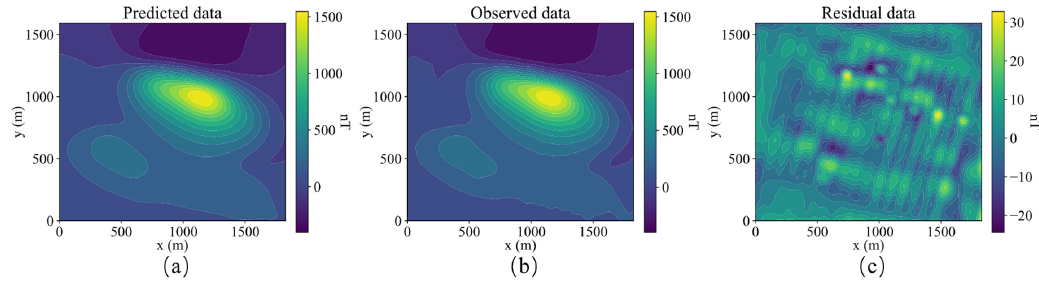
Figure 17. Contour plots of predicted data ( a ), observed data ( b ) and residual data ( c ). Figure 18 shows the polar scatter plots of inverted magnetization inclination and declination with large, medium, and small cutoff values. When a large cutoff value is applied, the average value of inverted magnetization declination is 25 ◦ , as shown by the regions with large magnetization amplitudes in Figure 11. There are two distinct magnetization inclinations, around 30 ◦ and 45 ◦ . When the cutoff value becomes smaller, the magnetization direction of more regions can be displayed.